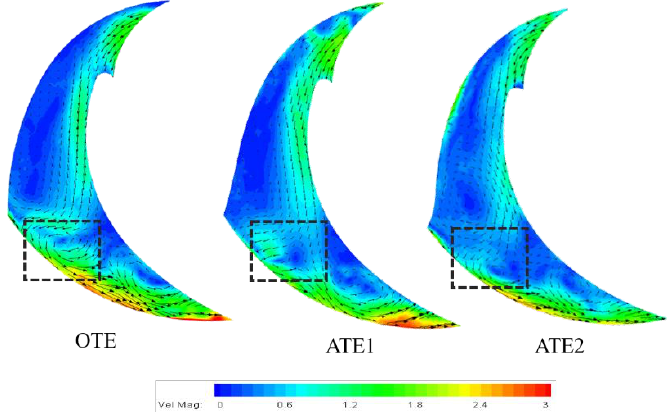
Figure 6. Transient flow fields at 0.2 Q BEP .